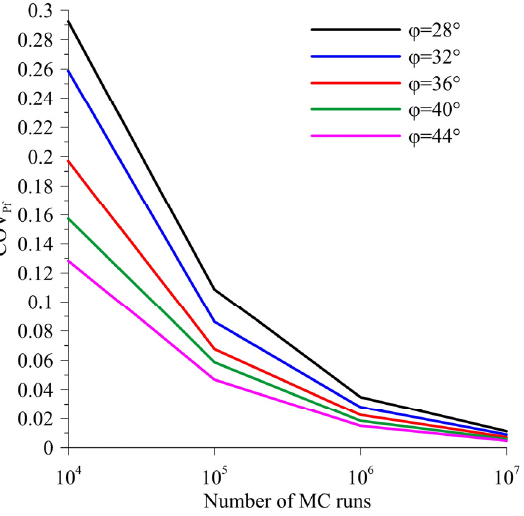
Figure 10. Relationship between the (cid:1829)(cid:1841)(cid:1848) (cid:3043)